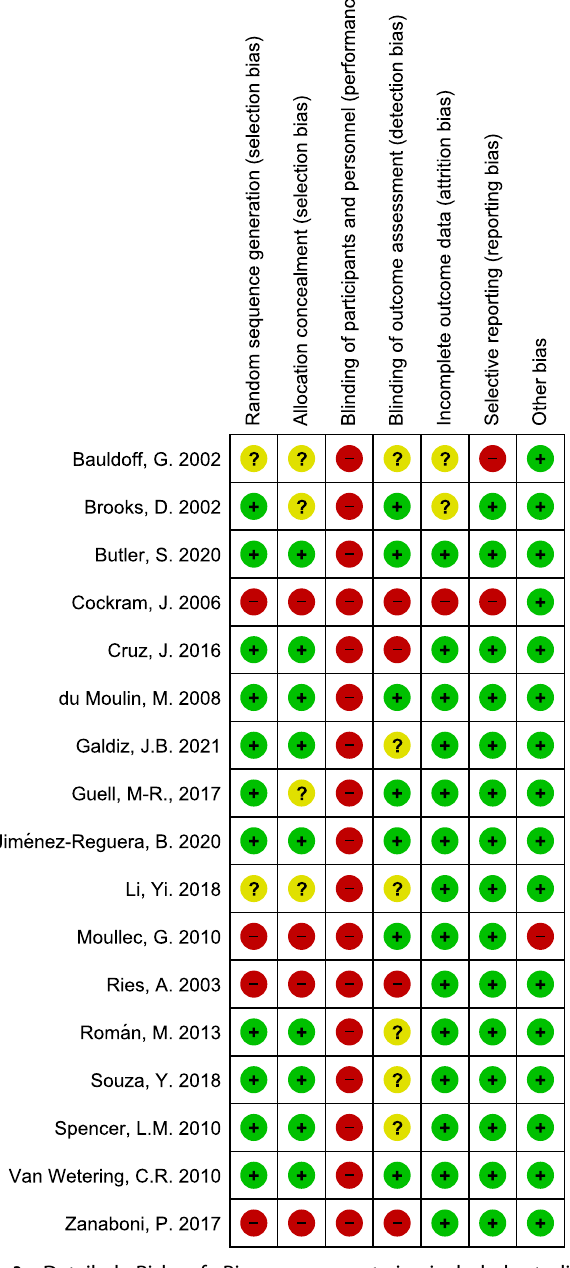
Fig. 2 Detailed Risk of Bias assessment in included studies according to GRADE